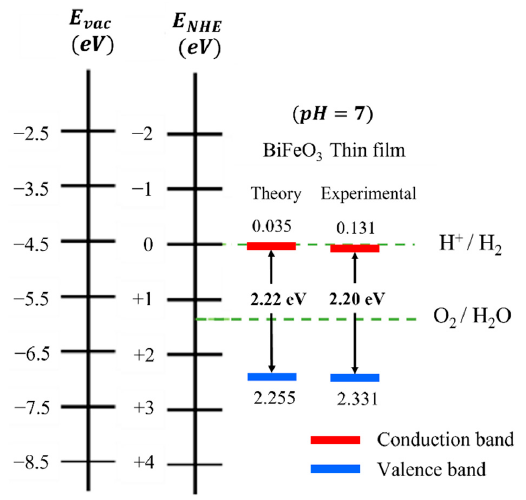
Figure 15. Band alignment of BiFeO 3 thin film extracted experimentally and computed theoretically.